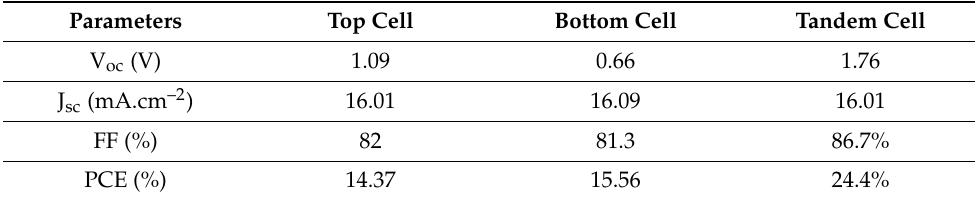
Table 3. Photovoltaic parameters of the top, bottom, and tandem